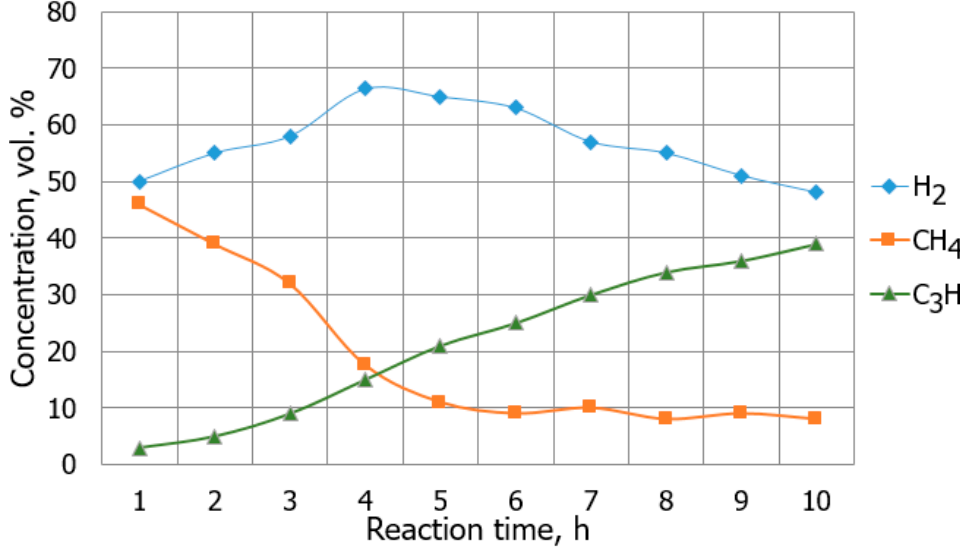
Figure 9. Reaction time dependence of catalytic propane pyrolysis products concentration using a stirrer at reactor temperature 590 ± 10 °C; curves of the average concentration of propane pyrolysis products based on 150 samples are presented.